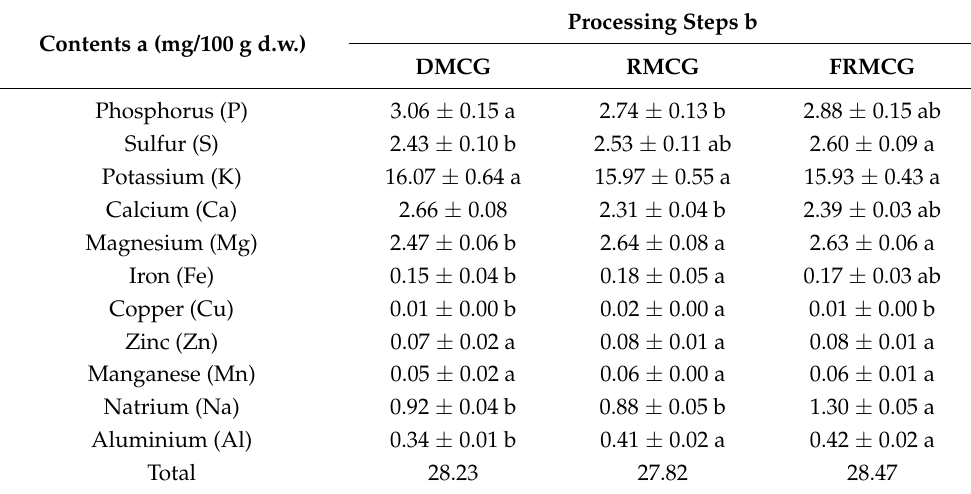
Table 3. Change of the mineral contents during food processing steps of mountain-cultivated ginseng with the cocktail lactic acid bacteria. Contents a (mg/100 g d.w.)